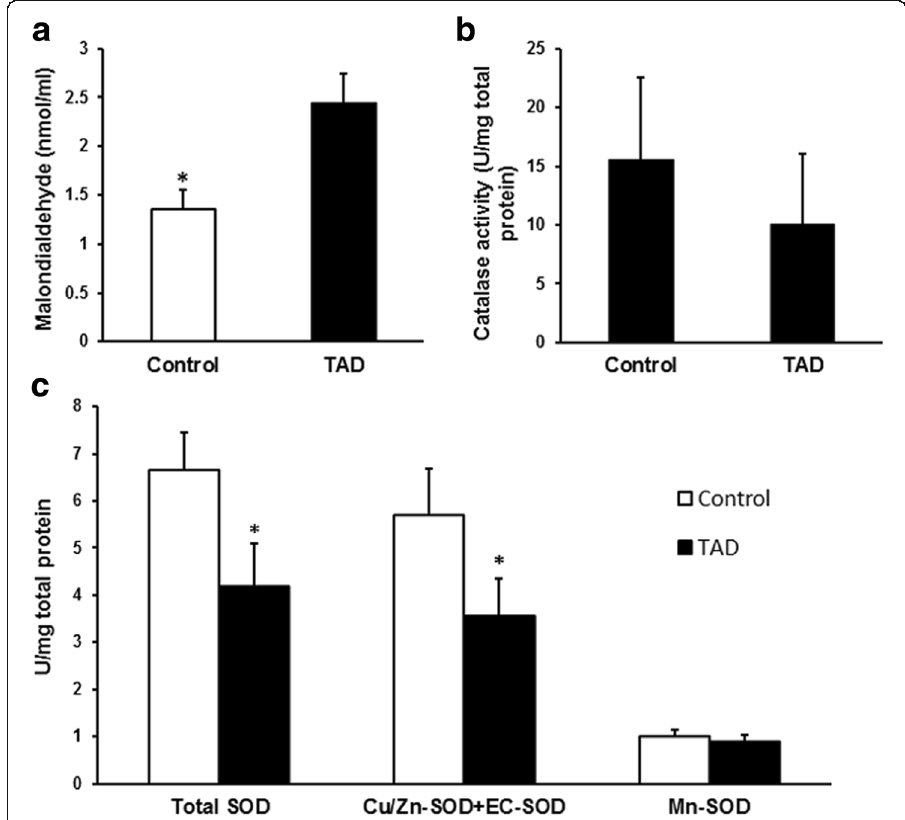
Fig. 3 Malondialdehyde levels and catalase and SOD activities in TAD samples. a – The levels of malondialdehyde in the aortic media were significantly higher in the TAD group (* p < 0.05). b – Catalase activity was lower in the TAD group, but the difference was not statistically significant. c – Total SOD activity and activities of Cu/Zn-SOD plus EC-SOD had both decreased in the TAD group compared with the control group, but no significant differences in Mn-SOD activity were found between